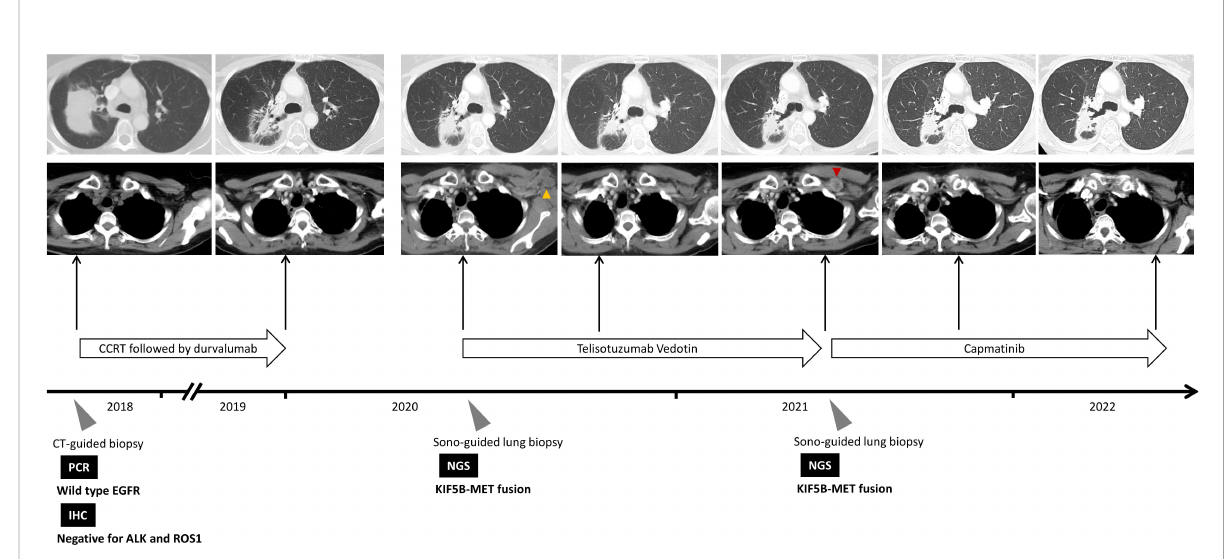
FIGURE 2 Summary of treatment courses mentioned in this case report. The yellow arrowhead indicate the target lesion at disease progression after consolidation therapy with durvalumab, whereas the red arrowhead indicates the target lesion at disease progression after the use of Telisotuzumab Vedotin. ALK , anaplastic lymphoma kinase; CCRT, concurrent chemoradiotherapy; CT, computed tomography; EGFR , epidermal growth factor receptor; IHC, immunohistochemical; NGS, next-generation sequencing; PCR, polymerase chain reaction; ROS1 , ROS proto-Oncogene